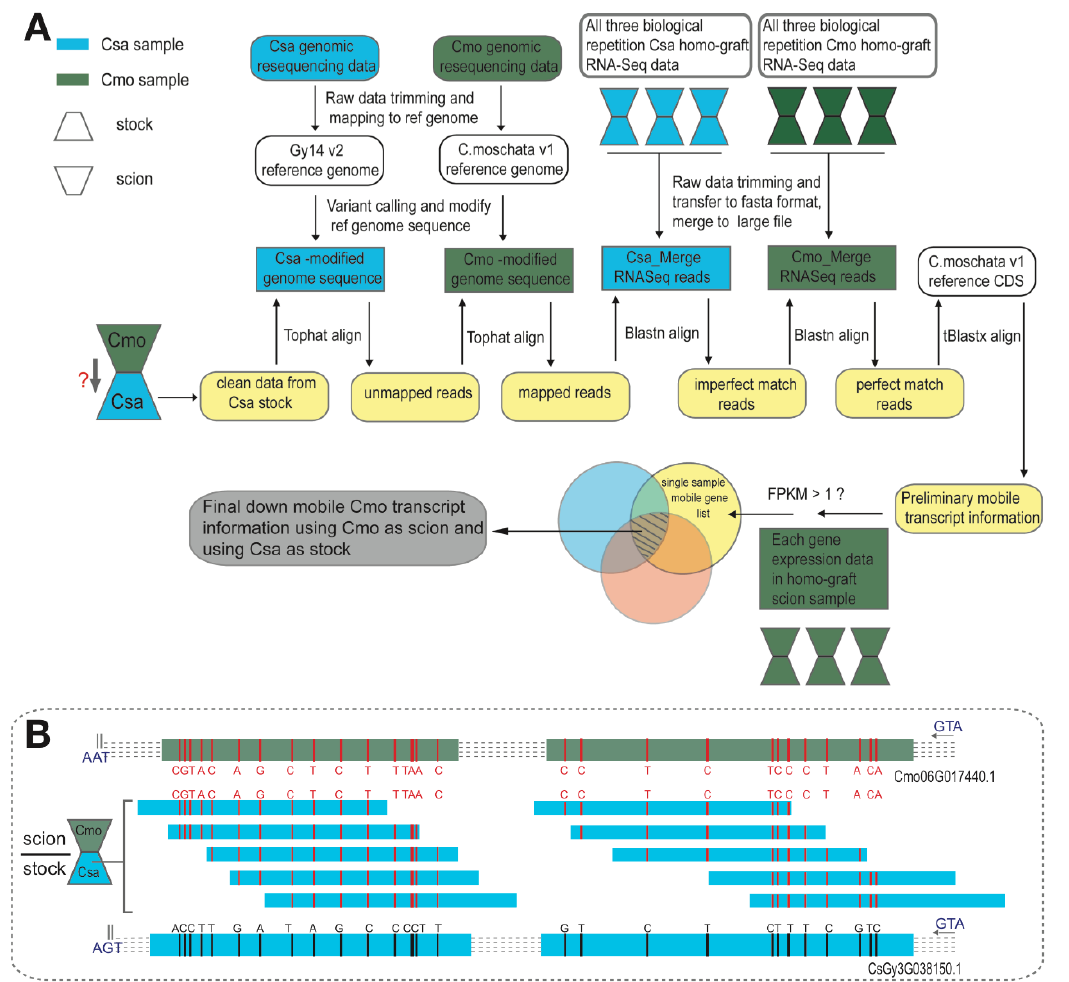
Figure 2. Single Nucleotide Polymorphism (SNP) identification pipeline and detection of mobile RNA. ( A ) Schematic of bioinformatics pipeline used for processing RNA-Seq and DNA-Seq data obtained from Cucumis sativus (Csa) and Cucurbitea moschata (Cmo) heterografts. Pipeline features include genomic resequencing data processing, variant calling, and mobile transcript detection. Data obtained from Csa samples are colored in blue hues and data from Cmo in dark green hues. Individual pipeline steps are described in the Materials and Methods Section. ( B ) Example read count frequencies for informative SNPs of predicted scion mobile transcripts in stock. Several reads of one transcript coming from Csa stock (blue bar in middle) carry two or more diagnostic SNP loci (red lines) after comparing with C. sativus transcript CsGy3G038150.1 (blue bar in bottom), but without SNP loci comparing with C. moschata transcript Cmo06G017440.1 (green bar with red lines upon) .